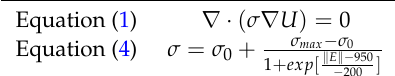
Table 1. Governing equations used to implement the irreversible electroporation (IRE) model.